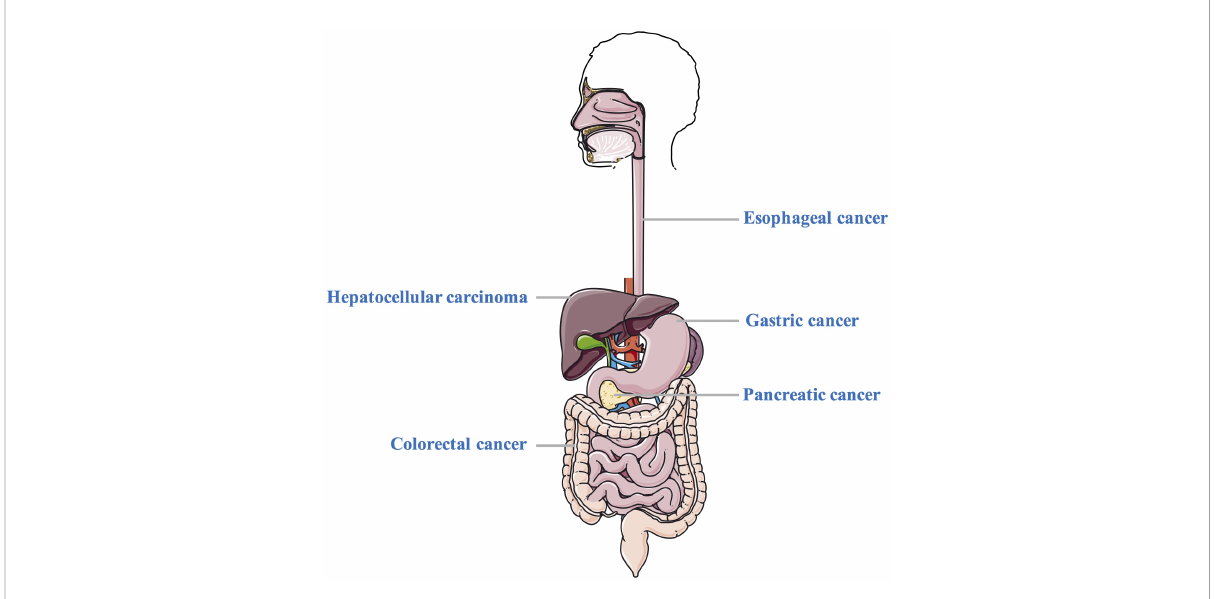
FIGURE 2 The effects of melatonin on various gastrointestinal cancer. This fi gure shows the examples of several common gastrointestinal cancer (including EC, GC, HCC, PC, and CRC) where melatonin exhibits protective effects EC, esophageal cancer; GC, gastric cancer; HCC, hepatocellular carcinoma; PC, pancreatic cancer; CRC, colorectal